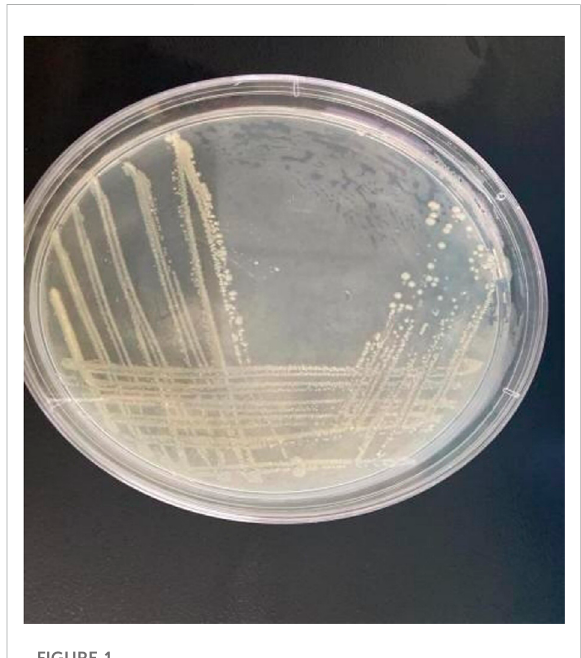
FIGURE 1 The morphology of strain AO-06 on LB medium.